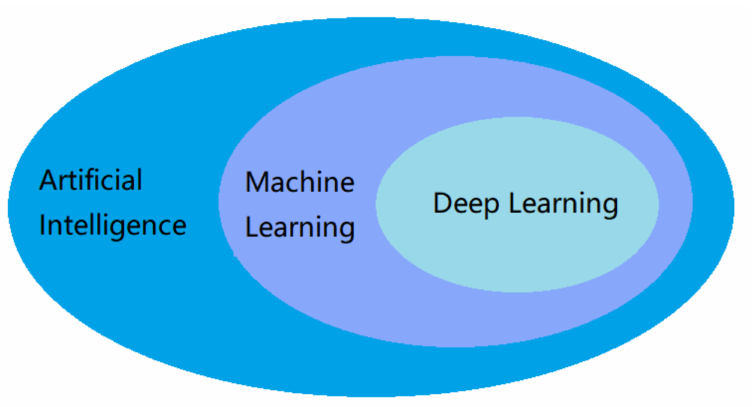
Figure 1. Relationship among Artificial Intelligence, Machine Learning and Deep